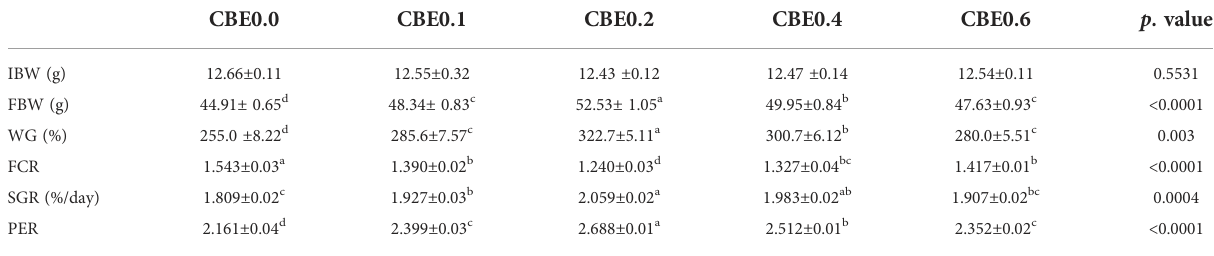
TABLE 4 Growth and feed utilization parameters of Nile tilapia ( Oreochromis niloticus ) fed on different doses of for 10